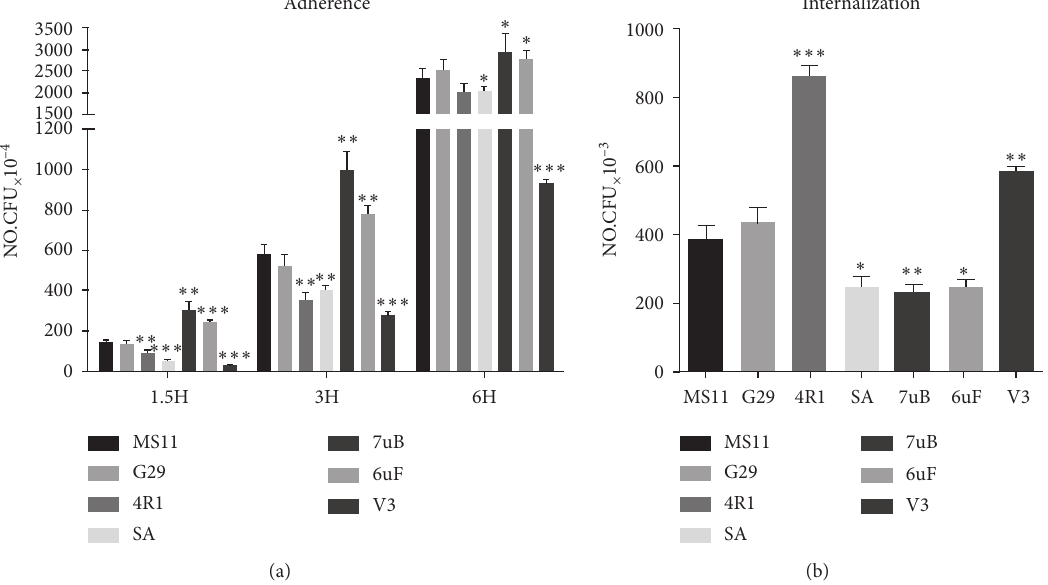
Figure 4: The (a) adherence and (b) internalization of reisolates and input strain (MS11) to human Chang conjunctiva cells. The level of adherence to cells was calculated by determining the cell-associated CFUs of the host cell monolayers (coincubation for 1.5 to 6h after an incubation period of 24h). For internalization, an approach similar to adherence assays by killing the extracellular bacteria with 100 μ g/ml (final concentration) gentamicin as previously described. The number of internalized bacteria was determined by counting CFUs recovered following gentamicin treatment. ∗∗∗ p < 0 . 001. ∗∗ p < 0 . 01. ∗ p < 0 .